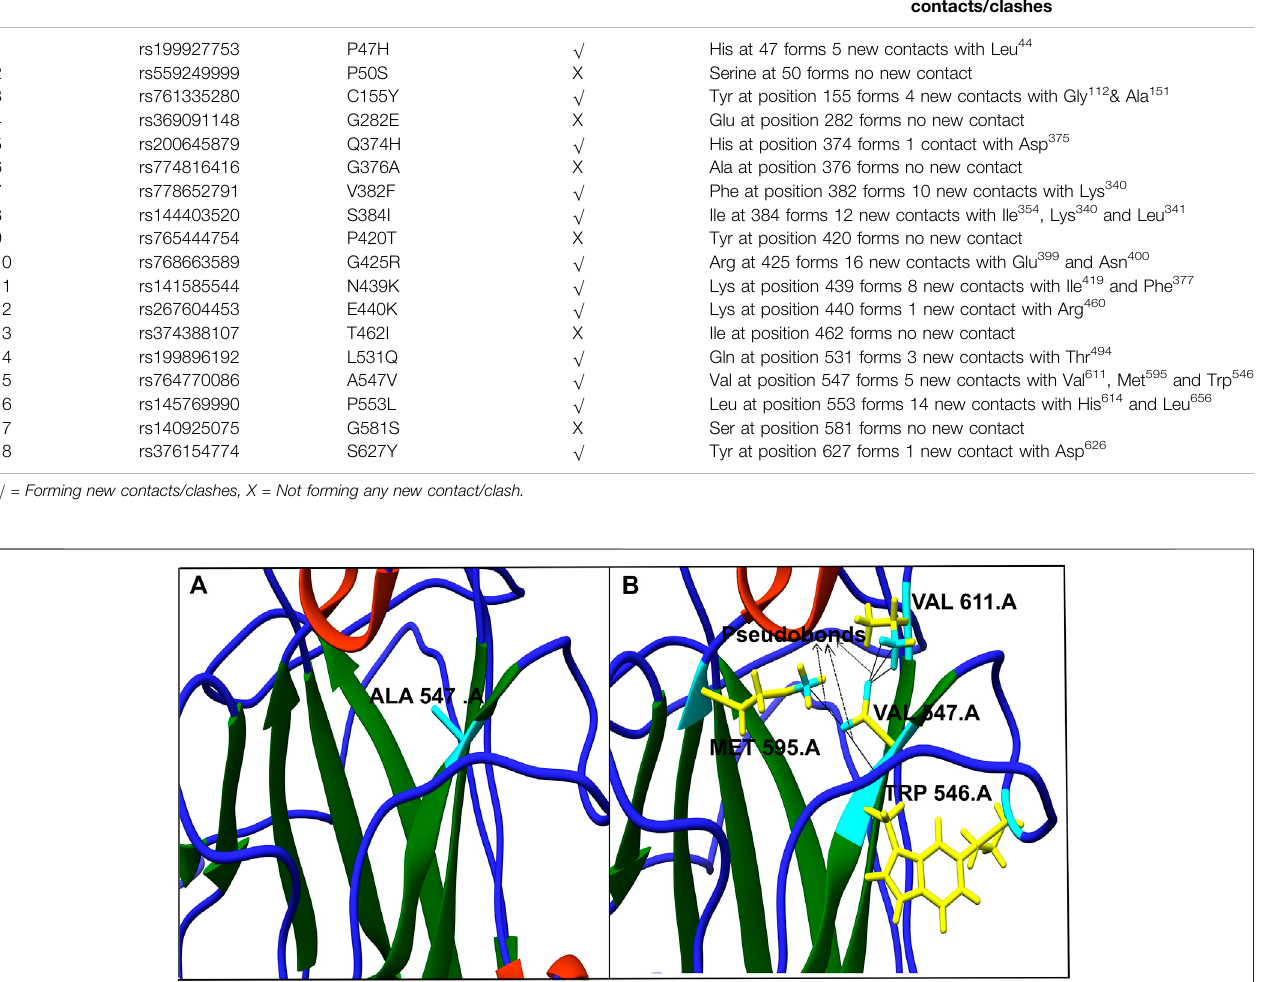
TABLE 4 | List of 18 deleterious SNPs along with the possible new network of clashes/contacts formed by the substituted amino acids at the corresponding positions as predicted by Chimera 1.11. S.No